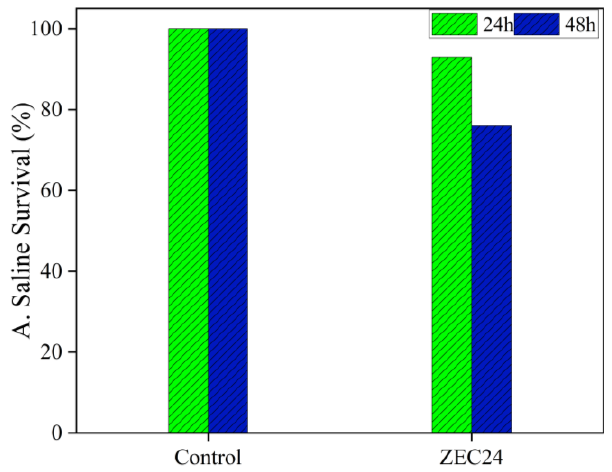
Figure 7. Ecotoxicity essay using Artemia salina.